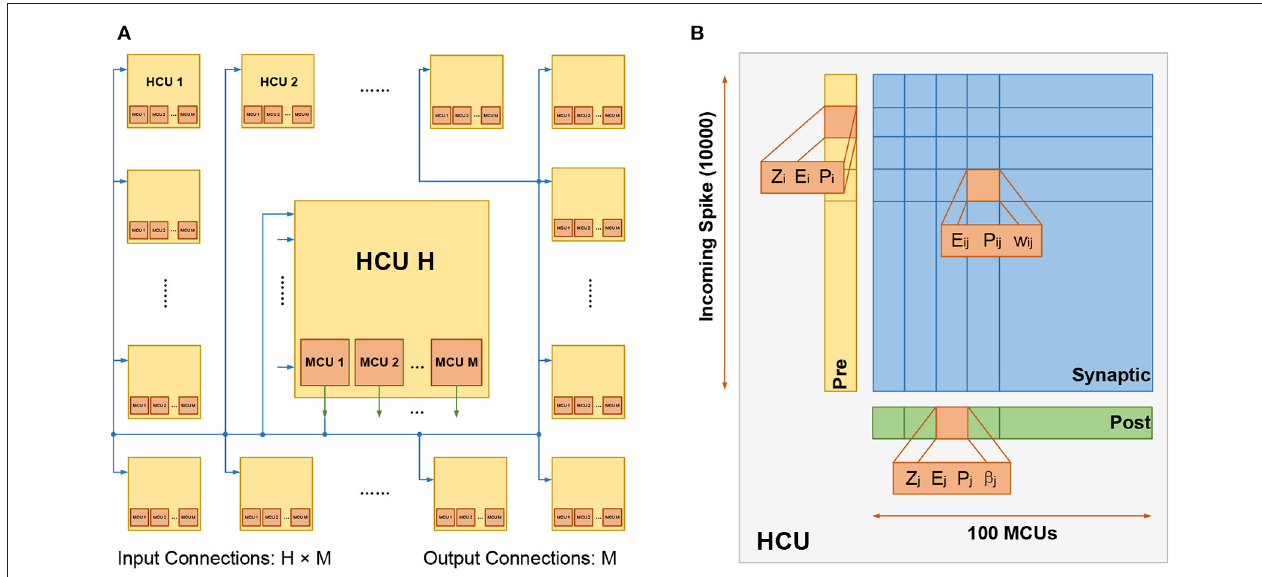
FIGURE 2 | (A) The original BCPNN learning rule (adapted after Tully et al., 2014). (B) The simplified BCPNN learning rule without E trace.